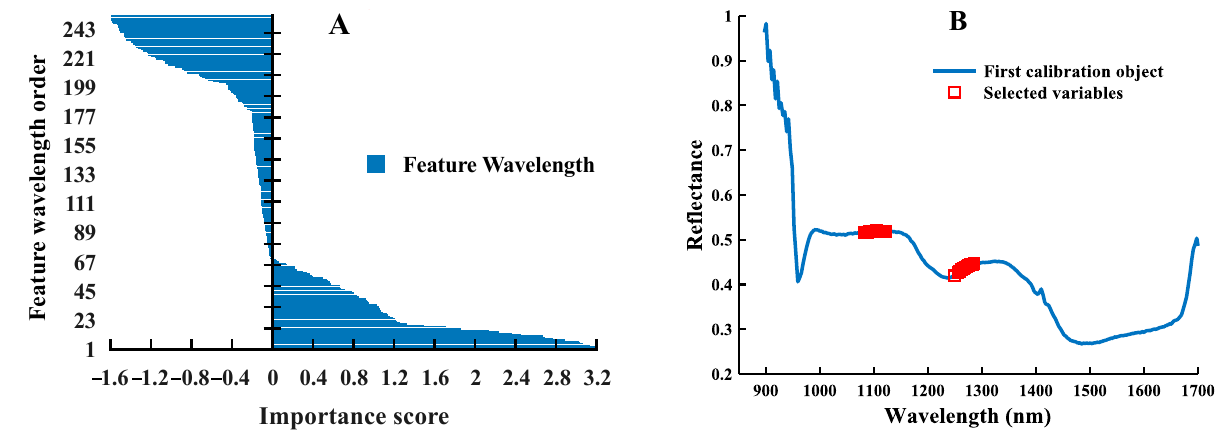
15 of 22 Figure 10. CARS selected feature wavelengths: ( A ) the value of RMSECV varies with the number of sampling; ( B ) the value of the variable’s coefficient. The result of the feature selection of the CNN-FES network proposed in this study is shown in Figure 11 (taking the spectral data processed by MSC as an example), and its score is of great significance for the object classification task. Figure 11A shows the IS at each wavelength obtained by inputting the raw hyperspectral data into the CNN-FES network. Since this method shows good selectivity, the IS value of some unimportant wavelengths will be less than 0, so 24 wavelength variables with higher values (the first 10%) can be selected (which can be adjusted according to the needs of practical applications), and the detailed distribution of its selection results on the spectral curve is shown in Figure 11B. It can be seen that there are more continuous wavelengths in the selected subset of effective wavelengths (the red “  ” represents selected variables). This situation indicates that the correlation between adjacent feature wavelengths is high, and the selected subset has less redundant information, which may be more favorable for the model to achieve better classification results. In addition, the selected feature wavelengths are all at and near the wave peaks on the average spectral curve, indicating that the wavelength selection method based on the CNN-FES model proposed in this study can effectively capture important feature information in the spectral data. Moreover, this